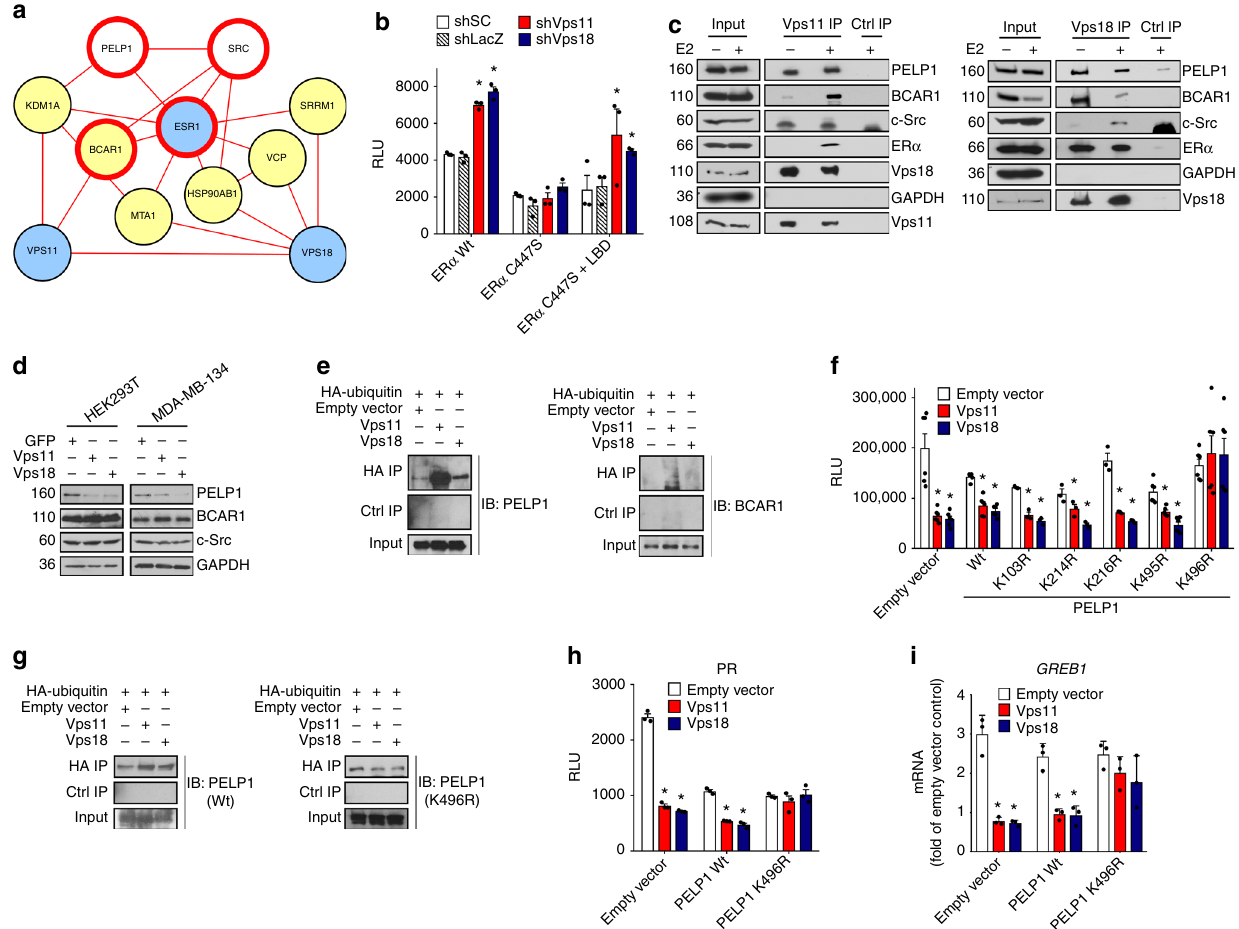
Fig. 5 Vps11/18 prevent membrane-associated ER α signaling by ubiquitinating PELP1. a Combined interactome of ER α (ESR1) and Vps11/18 (blue nodes) generated with Cytoscape using the plugin PpiMapBuilder (https://goo.gl/GusMZG). The common interactors are in yellow. Proteins in white nodes do not directly interact with Vps11/18 and nodes with a bold red line represent the proteins that are associated with the membrane ER α pathway. b ER α reporter assays with HEK293T cells infected with the indicated shRNA constructs and overexpressing either wild-type ER α (Wt), an ER α palmitoylation mutant (ER α C447S) or the combination of full-length ER α C447S with the ligand binding domain of ER α (LBD) by itself. Cells were treated with E2 (mean ± s.e.m. with n = 3 biologically independent experiments). c Immunoblot of an immunoprecipitation experiment with extracts from MDA-MB-134 cells. A control immunoprecipitation was performed in parallel with a control IgG (Ctrl IP). The blots were probed for the proteins shown on the right. d Immunoblots of extracts from HEK293T and MDA-MB-134 cells overexpressing Vps11/18 for an extended period of 6 days. e Immunoblots of immunoprecipitated ubiquitinated proteins. Extracts from HEK293T cells overexpressing Vps11/18 along with HA-tagged ubiquitin were immunoprecipitated with an HA antibody and probed either for endogenous PELP1 (left) or BCAR1 (right). A control immunoprecipitation was performed in parallel with a control IgG (Ctrl IP). f ER α reporter assays with HEK293T cells overexpressing Vps11/18 along with wild-type (Wt) PELP1 or the indicated point mutants of PELP1. g In vivo ubiquitination assays as in e with exogenously expressed wild-type and mutant PELP1 as indicated. h Luciferase reporter assays for PR in HEK293T cells overexpressing Vps11/18 along with wild-type or mutant PELP1 (mean ± s.e.m. with n = 3 biologically independent experiments). P4, progesterone. i Quantitative RT-PCR analysis of the mRNA levels of the ER α target gene GREB1 in MDA-MB-134 cells overexpressing Vps11/18 along with the indicated proteins (mean ± s.e.m. with n = 3 biologically independent experiments). Asterisks indicate signi fi cant differences with the corresponding negative controls with p -values < 0.05. Statistical signi fi cance was determined with unpaired and two-sided Student ’ s t -tests.